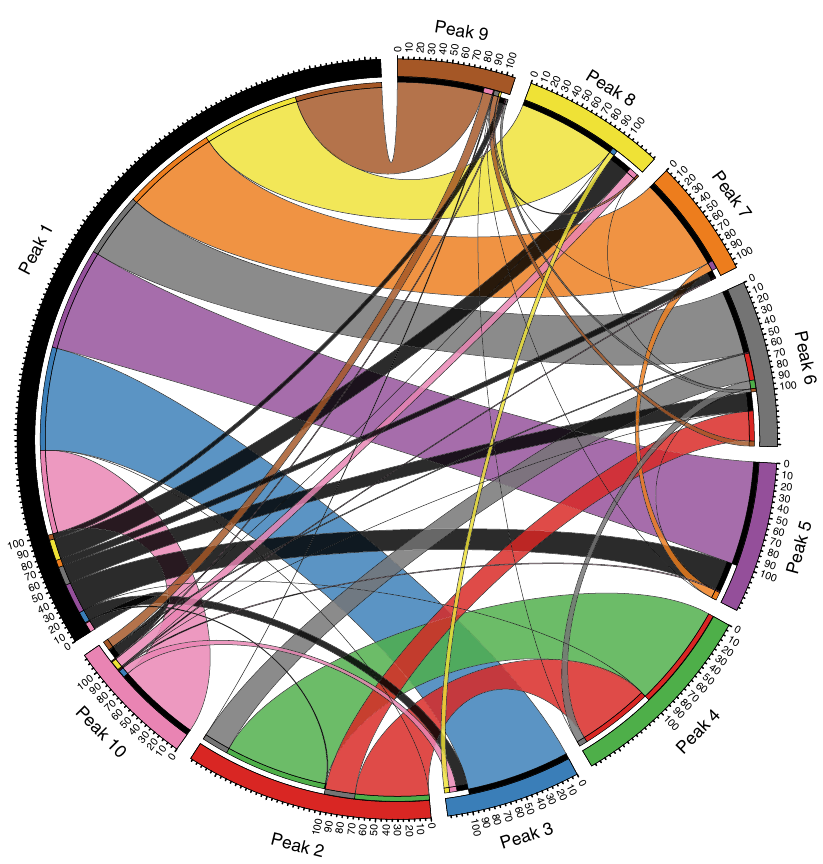
Fig. 4 Circos plot demonstrating peak 1 to be the most densely connected peak in the inferred landscape. A zero-temperature Monte Carlo procedure (see the “ Methods ” section) was used to obtain the pathways connecting different peaks in the landscape. For better visualization, only the pathways among the top 10 peaks are shown. The segments in the outer part of the circle, representing the peaks, are colored according to the scheme in Fig. 3. The ribbons, representing the pathways that connect the peaks, are colored according to the peak from which the trajectory originated. The width of each ribbon represents the percentage of the trajectories that originated from peak k and reached a peak k ’ k 0 ¼ 1 ; 2 ; ¼ ; 10 ; k 0 ≠ k ð Þ out of all the trajectories that did not reach peak k . This fi gure was generated using the web version of Circos 68 replicative capacity of each variant was measured (see Supplemen- tary Table 2 for the list of experimental fi tness measurements and Supplementary Note 7 for the criteria used to select these measurements from each study). Comparing these fi tness measure- ments with model energies revealed a strong negative correlation (Spearman correlation ρ s = − 0.83, p = 4.5 × 10 − 8 ; two-tailed test) (Fig. 5a). These results corroborate that our inferred model, based on peak 1 sequences only, serves as a meaningful proxy for the intrinsic vp1 fi tness landscape. We note that a model inferred based on all sequences or all sequences except those in peak 1 led to a comparatively much lower correlation ( ρ s = − 0.54, p = 2 × 10 − 3 and ρ s = − 0.51, p = 3 × 10 − 3 , respectively) (Supplementary Fig. 4), indicating that the remaining peaks in the landscape have a strong effect of vaccine-induced immune pressure and thus, do not clearly re fl ect the intrinsic fi tness constraints on natural PV evolution.